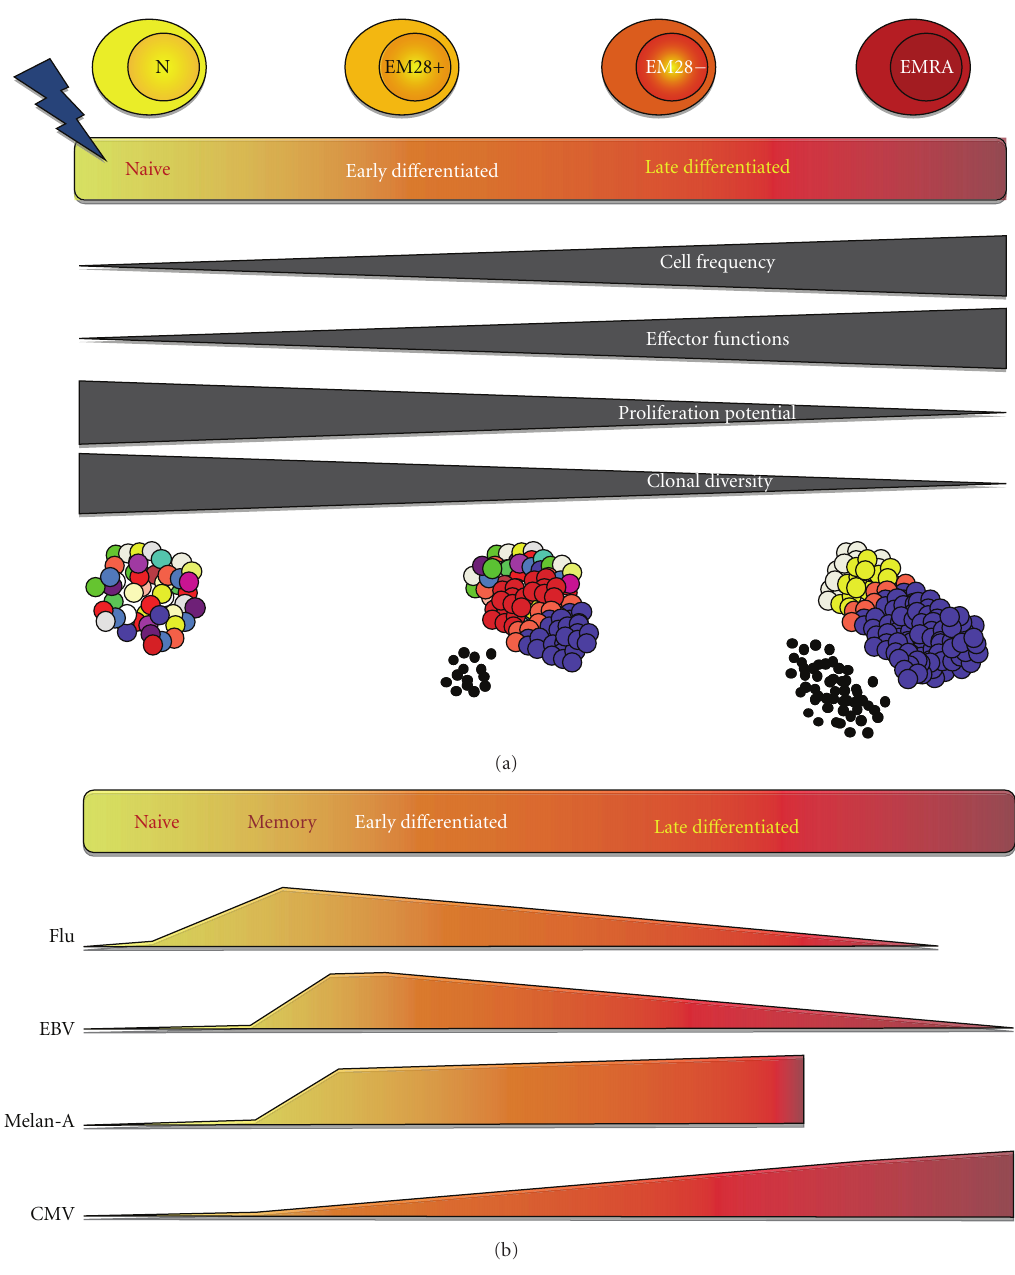
Figure 2: Model of CD8 T-cell di ff erentiation. (a) The highly diverse naive T-cell compartment contains T-cell clonotypes of very low frequency (represented by one color), and null expression of e ff ector mediators but high potential for proliferation in response to antigen. Following encounter with cognate antigen, CD8 T-cells are activated and begin a process of cellular di ff erentiation characterized by a gradient of early- and late-di ff erentiated cellular states, that can be described by changes within four major parameters as depicted by dark grey blocks. As a result of the massive cellular proliferation that ensues activation, there is an increase in the frequency of T-cells and a restriction in the TCR diversity, since the pool of primed di ff erentiated T-cells is composed of a small number of clonally expanded T-cells (blue, white, yellow, and orange T-cells). Concomitantly, there is a decrease in proliferative potential from naive and early di ff erentiated T-cell subsets towards highly di ff erentiated subsets. Moreover the accumulation of e ff ector functions (high production of e ff ector molecules, small black dots) in these expanded populations of T-cells defines further maturation of di ff erentiated T-cells. (b) The degree of di ff erentiation of T-cells along this spectrum has been shown to vary with antigen specificity. As such, the antigen-specific responses against influenza virus and against persistent EBV and CMV viruses are compared with the tumor-specific response against the Melan-A antigen, while taking into account the four parameters described in (a). EBV-specific cells are more di ff erentiated than influenza-specific cells but less so than CMV-specific cells which are composed primarily of highly di ff erentiated CD8 T-cells. While both early and late di ff erentiated subsets have also been identified in Melan-A specific responses, their proportions are highly variable between di ff erent patients following vaccination. In addition, tumor-specific responses contain a much lower fraction of highly di ff erentiated EMRA (e ff ector memory CD45RA+) cells compared with viral-specific